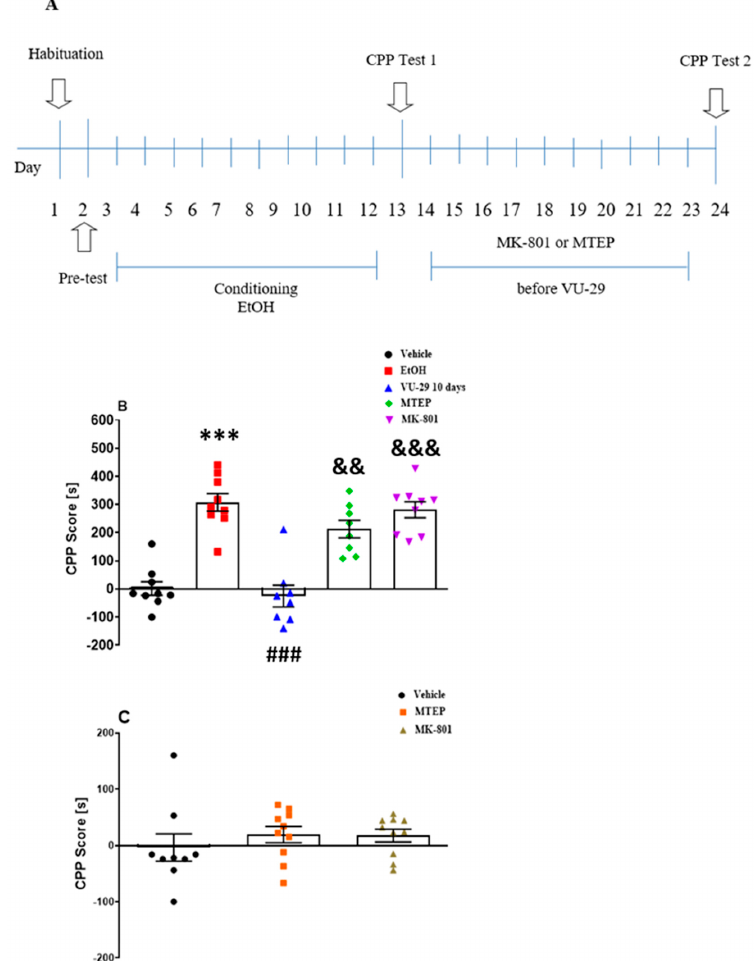
Figure 3. Experimental design for the influence of MK-801 and MTEP on the effect of VU-29 on the maintenance of ethanol-induced CPP ( A ). Data are shown as post-conditioning minus pre-conditioning time (s) spent in the drug-associated compartment in the CPP Test 2 ( B ). The influence of MK-801 and MTEP on CPP score in vehicle-treated rats in the CPP Test 2 ( C ). Dots represent individual measurements, the central horizontal mark is the mean, and error bars represent SEM. *** p < 0.001 vs. vehicle; ### p < 0.001 vs. ethanol-treated group; && p < 0.01, &&& p < 0.001 vs. 10 Day VU-29- treatment.